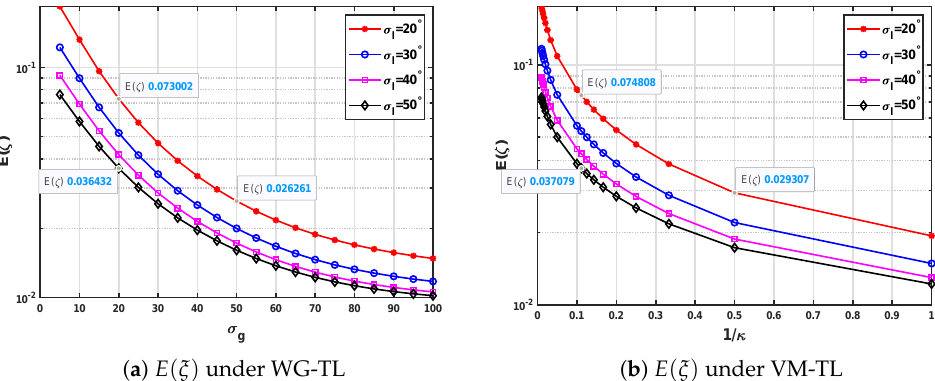
Figure 4. Expectations against angle spreads under WG-TL and VM-TL with the antenna number M =